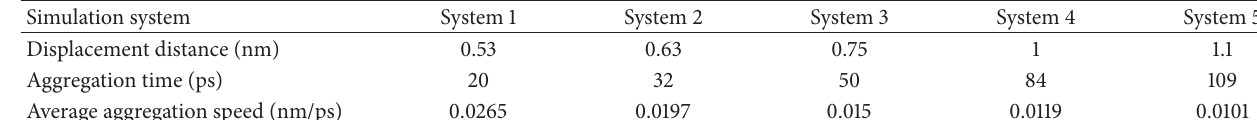
Table 2: Average aggregation speeds of systems 1–5.